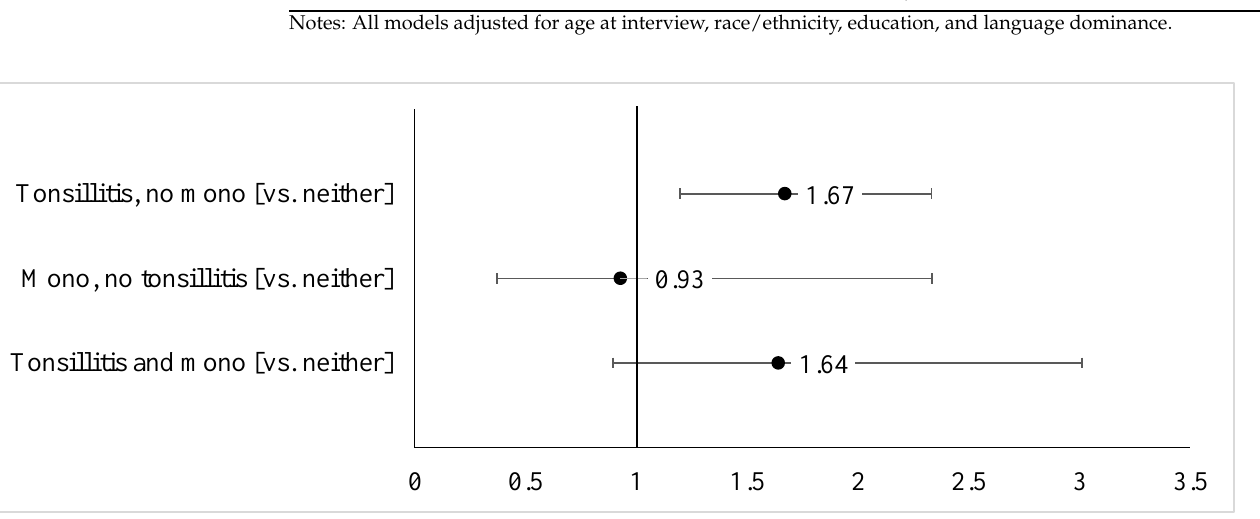
Figure 2. Adjusted associations of childhood infection (tonsillitis and mono) with early age at menarche (<12 years), relative risk ratios, and 95% confidence intervals. Notes: Models for childhood infection included complete responses for each of the infection history questions (N = 352). All models adjusted for age at interview, race/ethnicity, education, and language dominance. Model for ever vs. never tonsillitis also adjusted for ever mono. Model for ever vs. never mono also adjusted for ever tonsillitis.